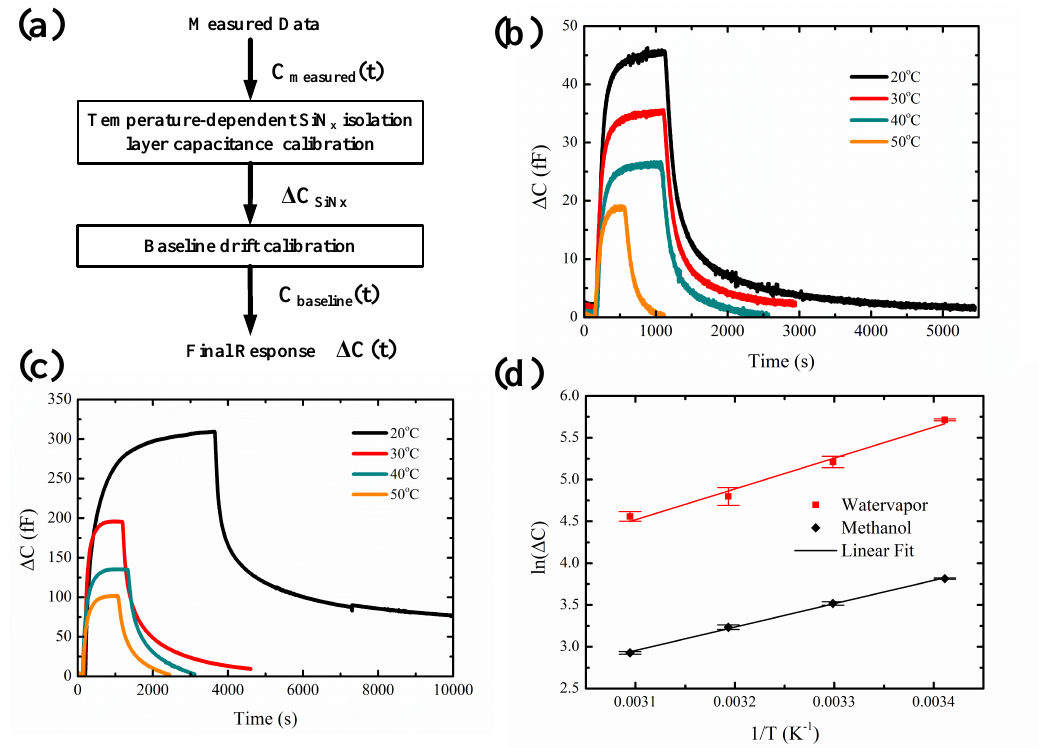
Figure 8. ( a ) Data analysis procedure. Capacitance response at different temperatures for 5000 ppm of ( b ) Methanol, ( c ) Water vapor, ( d ) Arrhenius relation between capacitance and